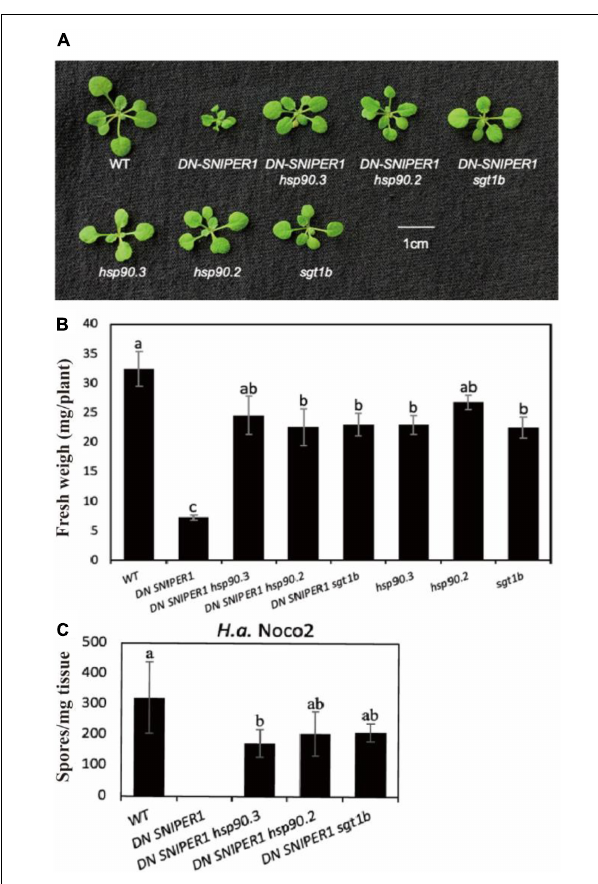
FIGURE 2 | Chaperone protein HSP90s and SGT1b contribute to the autoimmunity caused by overaccumulation of sensor NLRs. (A) Morphology of 3-week-old soil-grown plants of DN-SNIPER1 hsp90 , DN-SNIPER1 sgt1b double mutant at 23 ◦ C. (B) Weights of 3-week-old soil-grown plants of DN-SNIPER1 hsp90 , DN-SNIPER1 sgt1b double mutant at 23 ◦ C. (C) Quantification of H.a. Noco2 conidia growth on the leaf surface of Figure 1 . One-way ANOVA followed by Tukey’s post hoc test were performed for panels (B,C) . Statistical significance is indicated by different letters ( P < 0.05). Error bars represent mean SD ( n = 5).